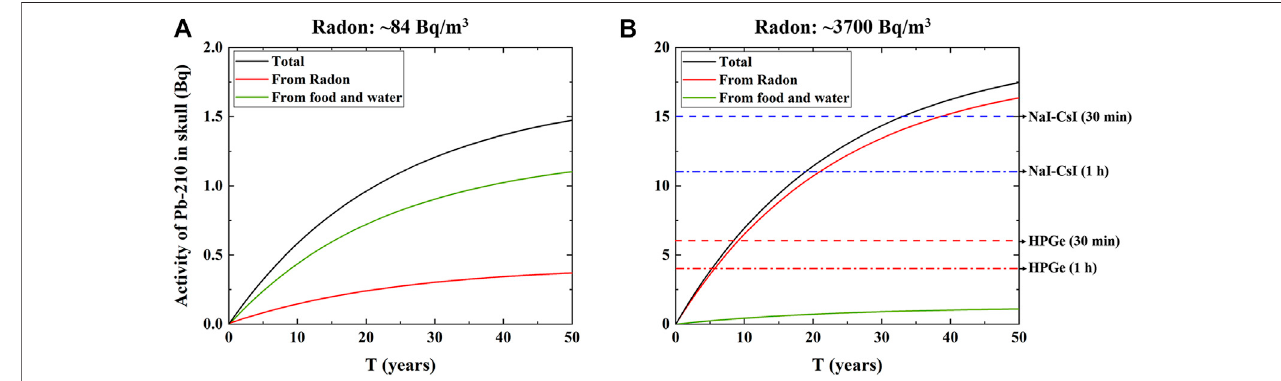
FIGURE6| Estimated Pb-210activity inskull originatingfrom various source asafunctionofexposure time.In (A) ,thedataareextractedfromLaureret al.(1999), wheretheradonconcentrationisestimated tobe ∼ 84 Bq/m 3 ;basedonthesamemodel, inconjunctionwiththeassumed radonconcentrationof3,700 Bq/m 3 ,thePb- 210 activity from various sources are presented in (B) comparing to the asymptotically achievable MDAs using NaI-CsI (blue) and HPGe (red) detectors under the measurement time of 30 min (dashed) and 1 h (dot-dashed).